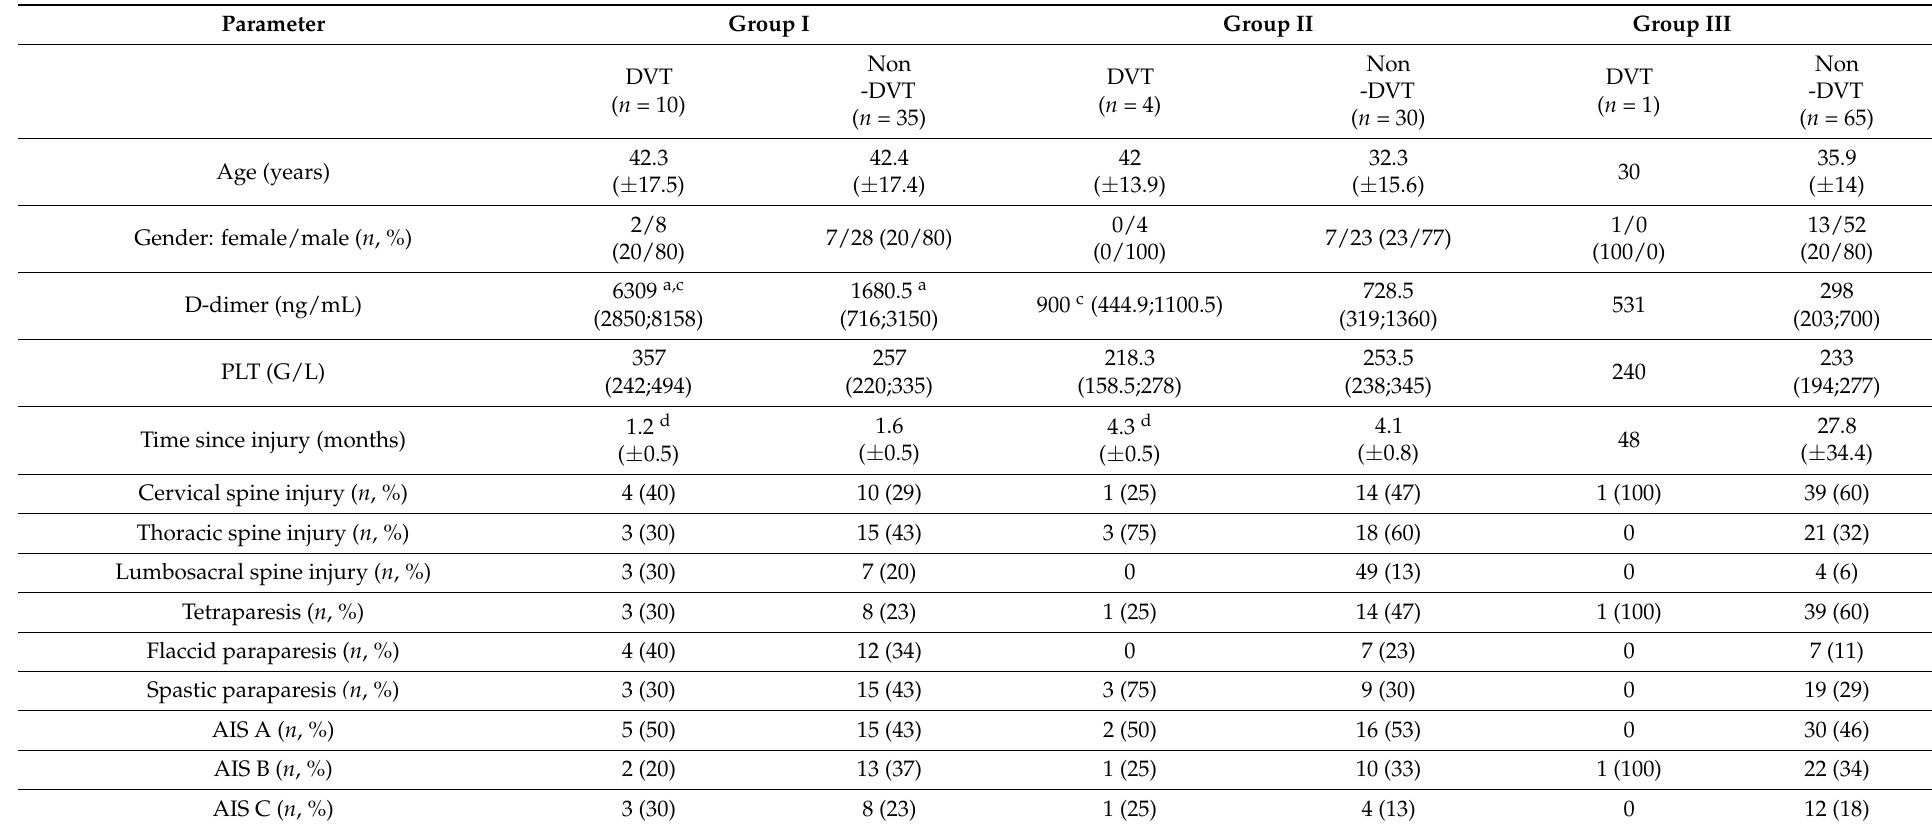
Table 3. Characteristics of patients with (DVT group) and without (non-DVT group) deep venous thrombosis in groups I, II, and